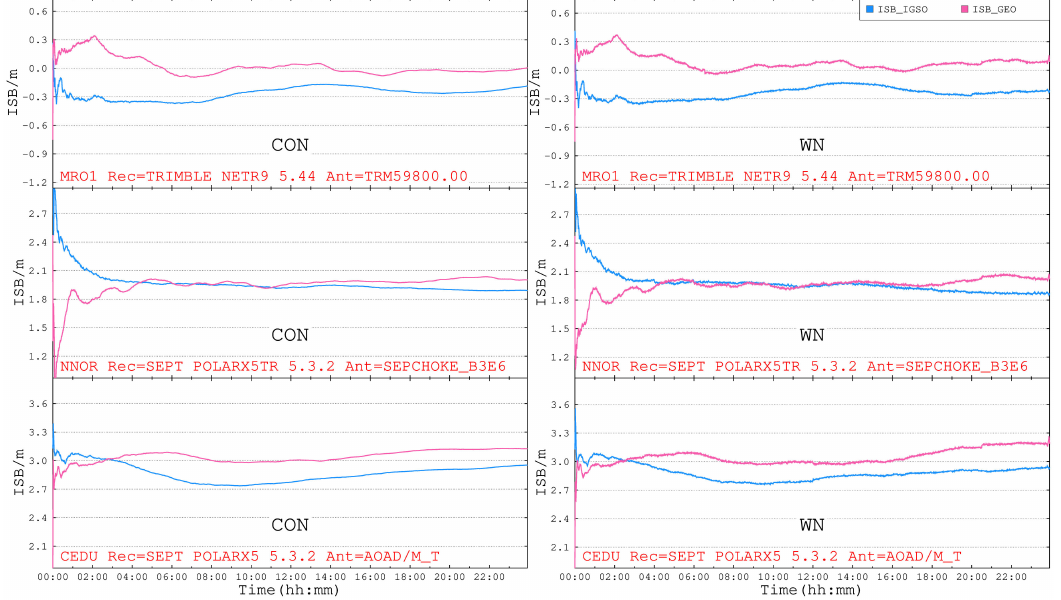
Figure 3. The time series of inter-system bias (ISB) for the BDS-2 IGSO + BDS-3 and BDS-2 GEO + BDS-3 combinations with the GBM precise products at DOY 110,